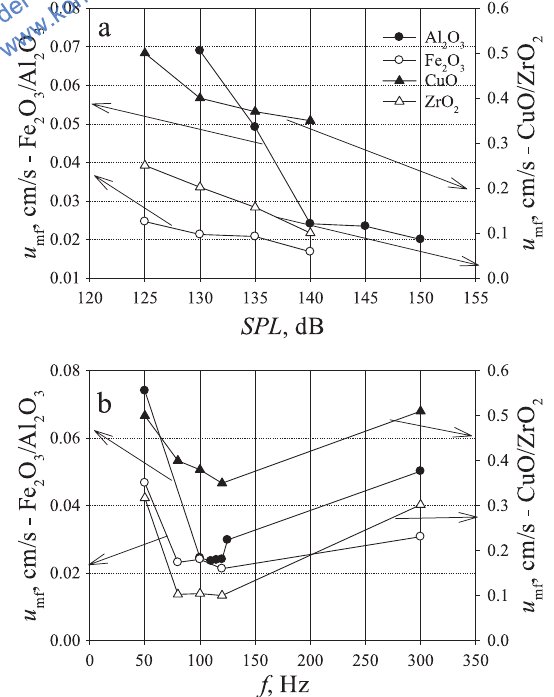
Fig. 4 Minimum fluidization velocity ( u mf ) as a function of (a) SPL at fixed frequency (120 Hz) and as a function of (b) frequency at fixed SPL (140